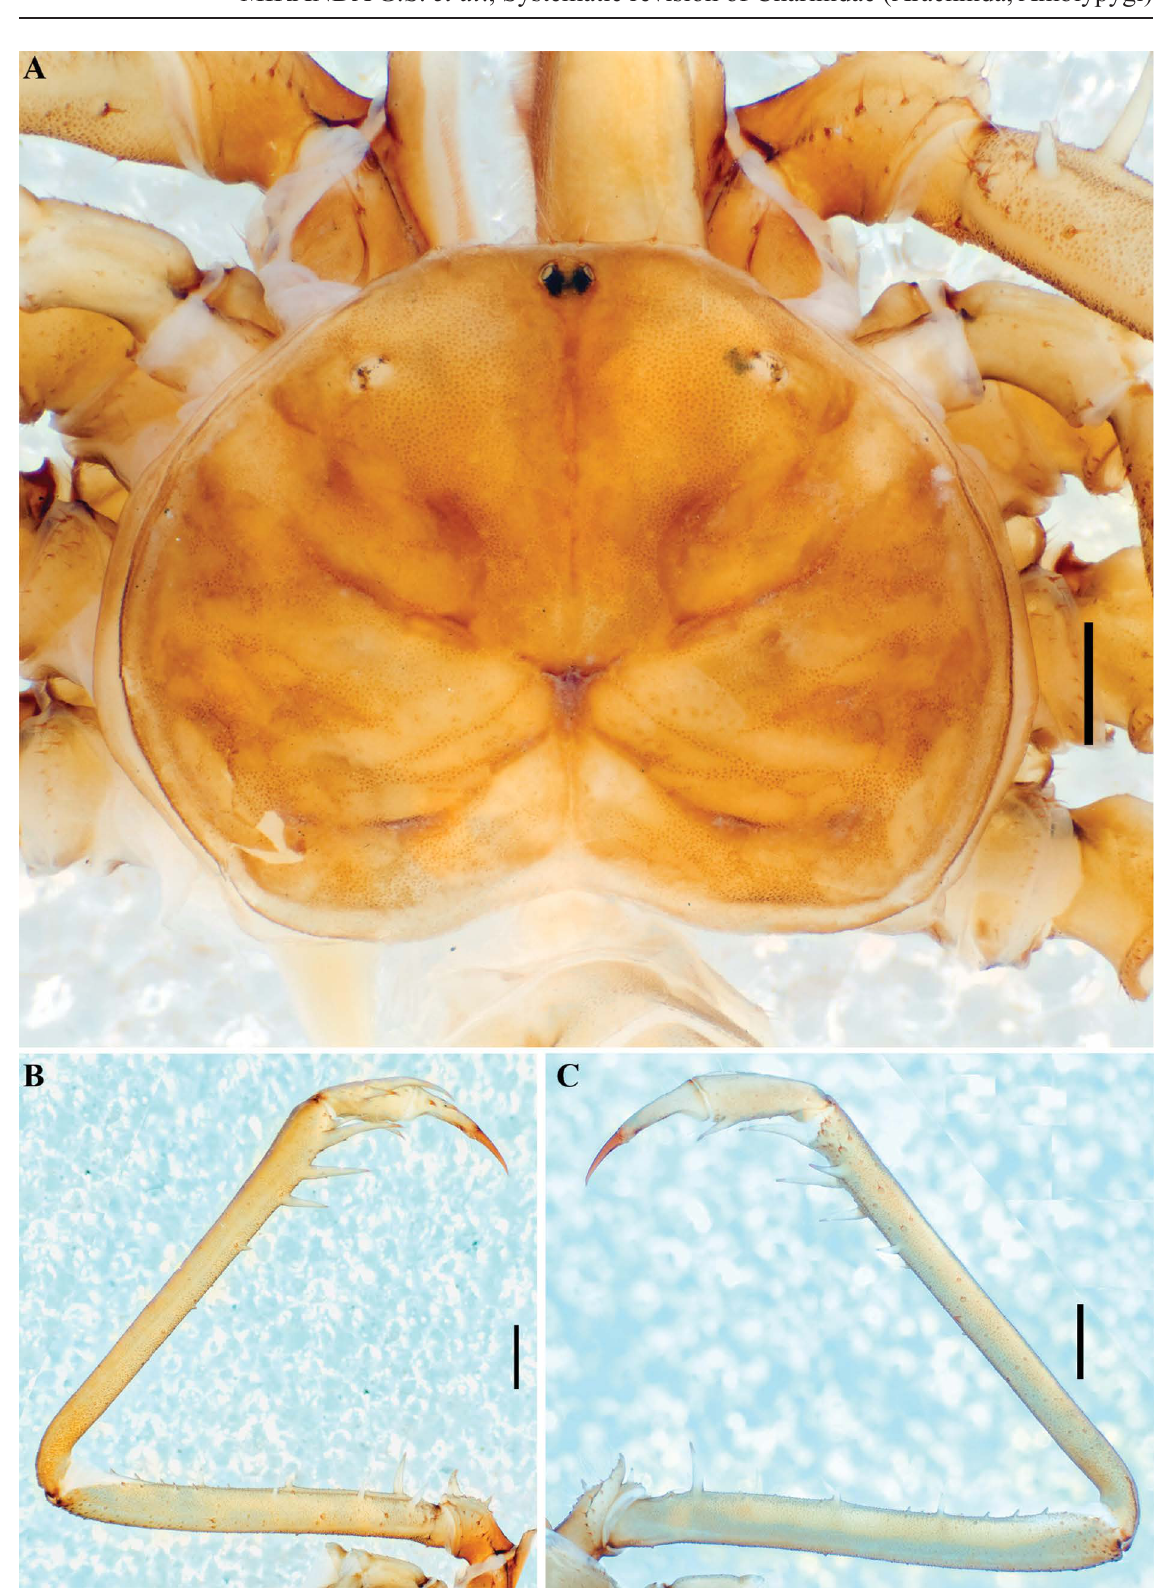
Fig. 89. Charinus fagei Weygoldt, 1972 (MNHN), general morphology, ♂. A . Carapace, dorsal view. B . Pedipalp, dorsal view. C . Pedipalp, ventral view. Scale bars: